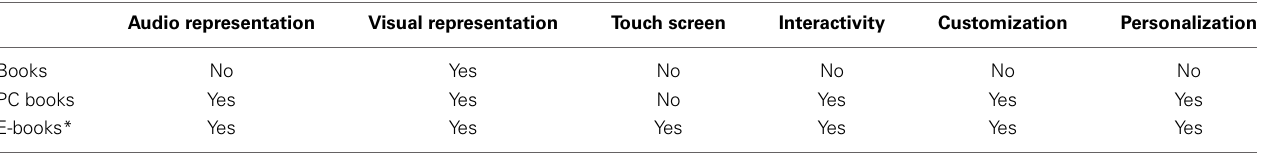
Table 1 | Overview of affordances of three main reading tools for